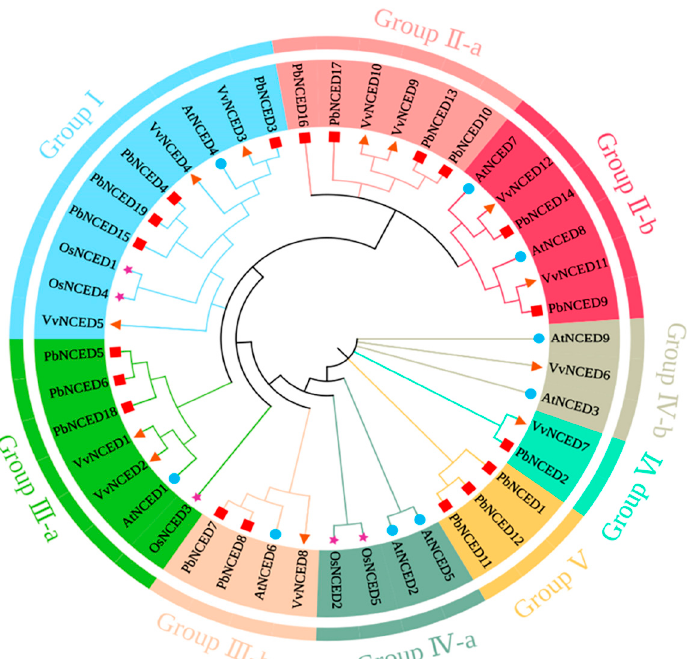
Figure 1. The phylogenetic relationship of the NCED gene family to Arabidopsis , rice, grape, and pear. Note: The blue solid dot represents Arabidopsis NCED protein, the purple solid pentagon represents rice NCED protein, the orange solid triangle represents grape NCED protein, and the red solid square represents pear NCED protein.